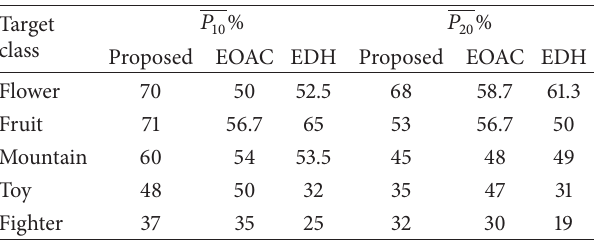
Table 1: Comparison of the average precision rates between pro- posed algorithm and others (EOAC,